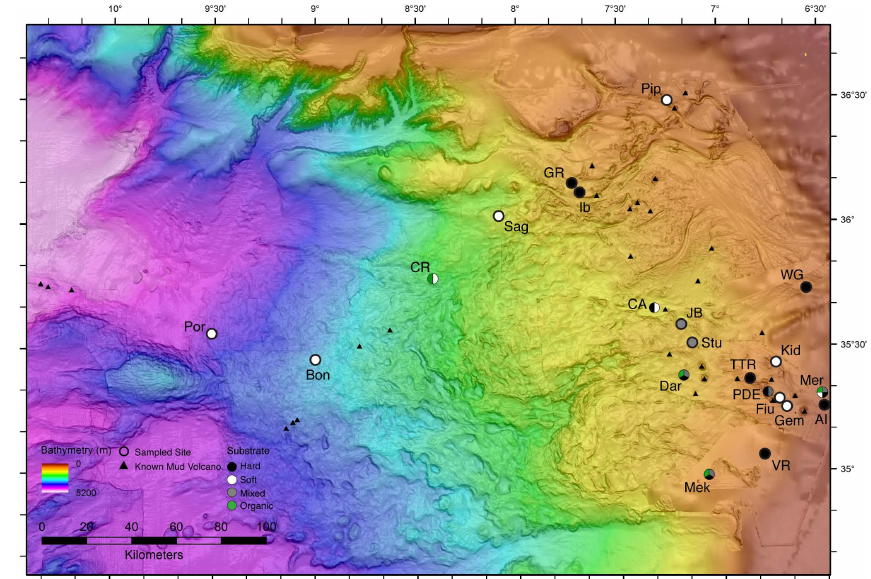
Fig. 1. Map of the study area (Gulf of Cadiz) showing samples locations from 225m (AI) to 3900m (Por). Multi-coloured circles repre- sent samples from different substrate types. The mud volcanoes are included in three sub-regions: (i) El Arraiche: AI: Al Idrisi ∗ ; Fiu: Fi´uza MV; Gem: Gemini MV; Kid: Kidd MV; Mer: Mercator MV; (ii) Carbonate Province: Dar: Darwin MV; Ib: Iberico MV ∗ ; JB: Jesus Baraza MV; Mek: Mekn`es ∗ MV; Pip: Pipoca MV; Stu: Student MV; TTR: TTR MV*; and (iii) Deep-water Field: Bon: Bonjardim MV; CA: Captain Arutyunov MV; CR: Carlos Ribeiro MV; Por: Porto MV; Sag: Sagres MV. In the MVs marked with ∗ gastropods were only found in sam- ples from hard substrata in adjacent habitats. The sites GR: Gaudalquivir Ridge; PDE: Pen Duick Escarpment; VR: Vernadsky ridge; WG: West of Gibraltar Strait are sites of accumulation of carbonate chimneys and concretions, and dead scleractinian framework. Colonization experiments were deployed in Mercator, Mekn`es and Darwin